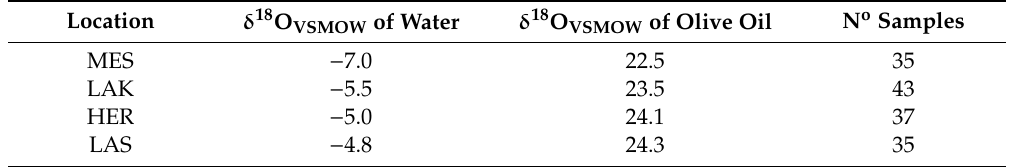
Table 3. Oxygen isotopic composition of olive oil and of spring water samples from the same regions. Peloponnese (MES and LAK) and South Greece (Crete-HER and LAS). Location δ 18 O VSMOW of